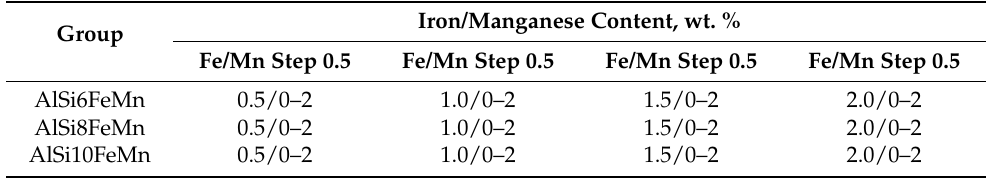
Table 3. Groups of investigated alloys leading to the individual isopleth.